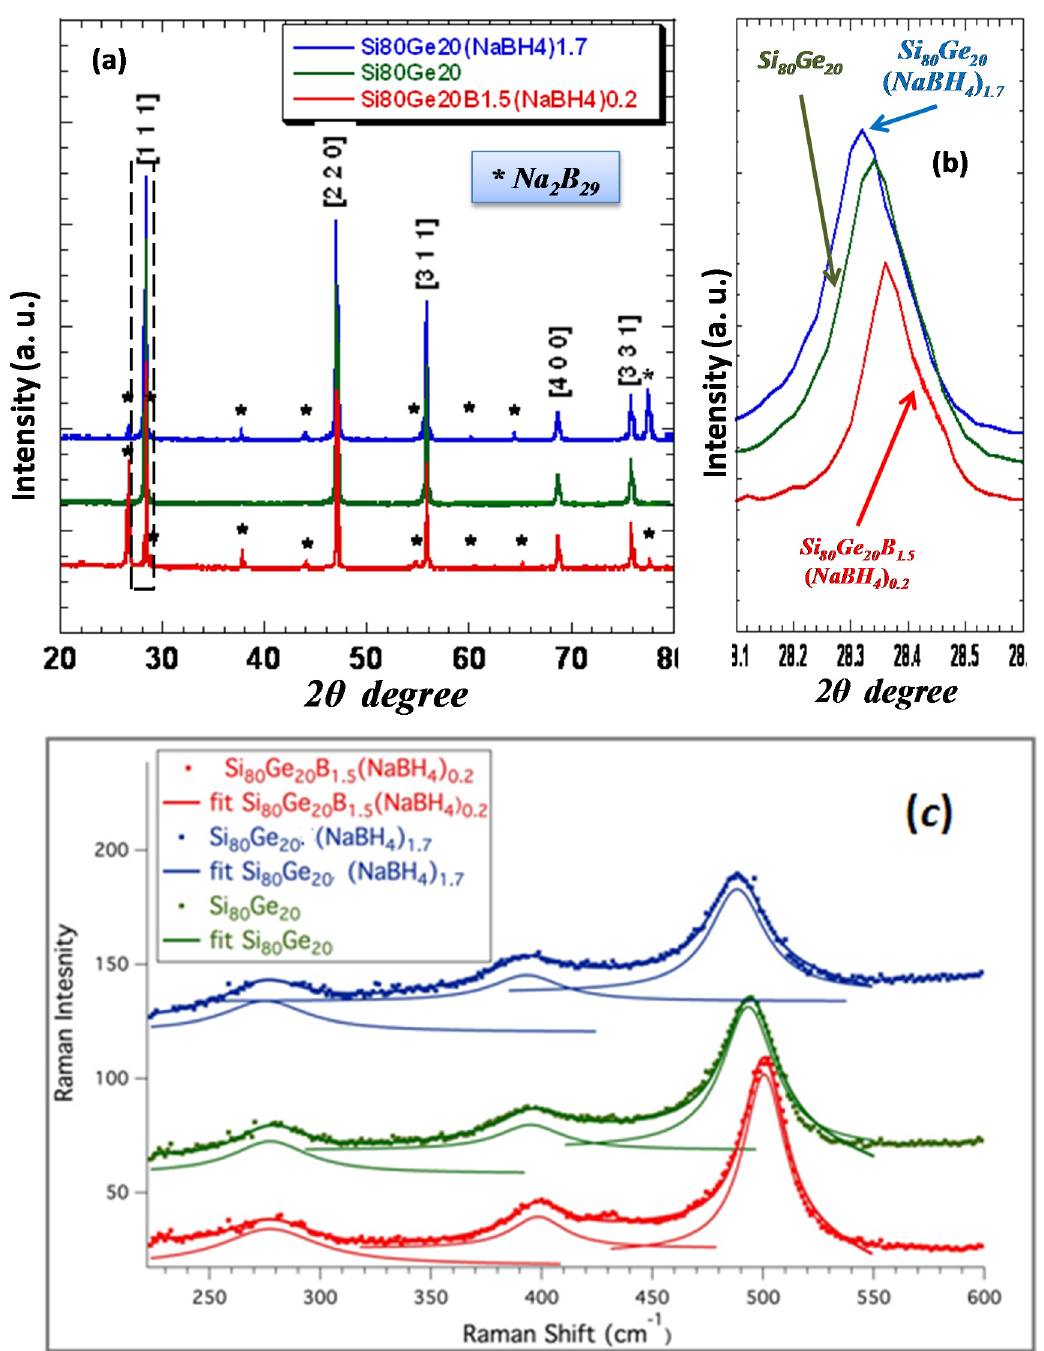
Figure 1. ( a ) XRD patterns of the sample dominantly doped with B, the sample doped dominantly with Na, and pristine SiGe ; ( b ) magnification of the (111) peak shift upon the Na and B doping, note that the peaks shift to the opposite direction; and ( c ) Raman peak shifting tracks with XRD peak